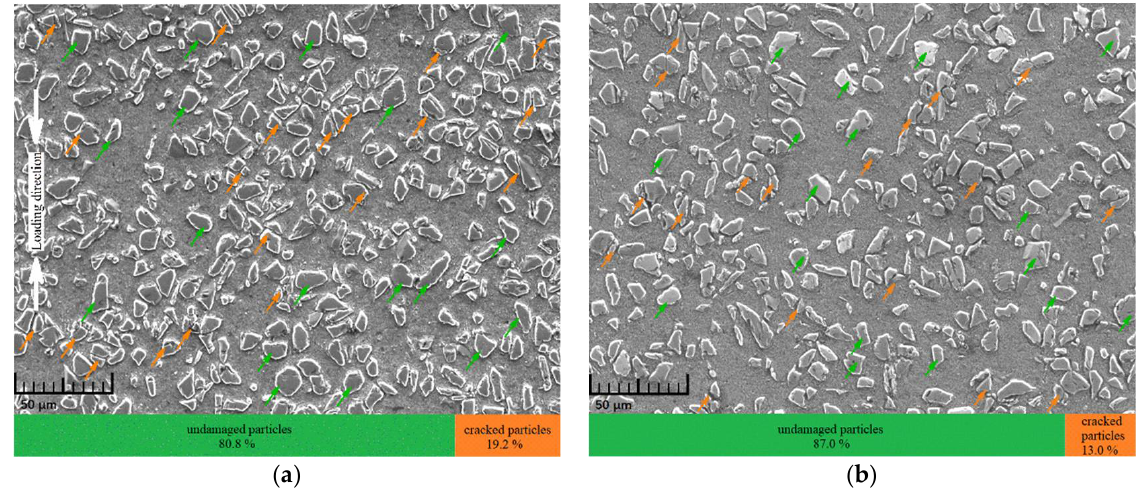
Figure 10. Micromorphology of specimens after 20% applied strain at 1600 s −1 . ( a ) SEM graph of the specimen at RT; ( b ) SEM graph of the specimen at 350 °C.